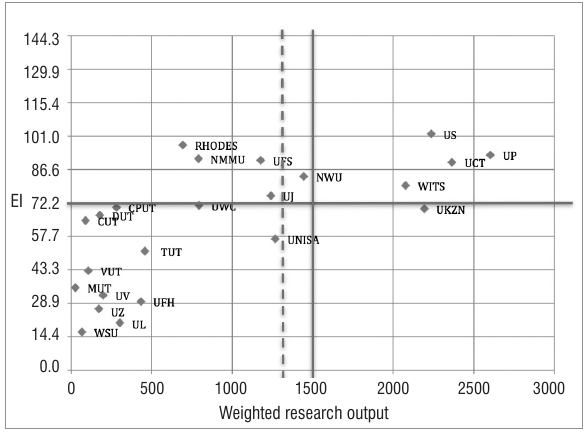
The 2011 total weighted research productivity versus the instructional/research professional staff Equity Index. Three universities – Rhodes, NMMU and UFS – fall firmly into the worst quadrant (upper left), which indicates poor equity profiles together with low research productivity. These universities need to urgently address